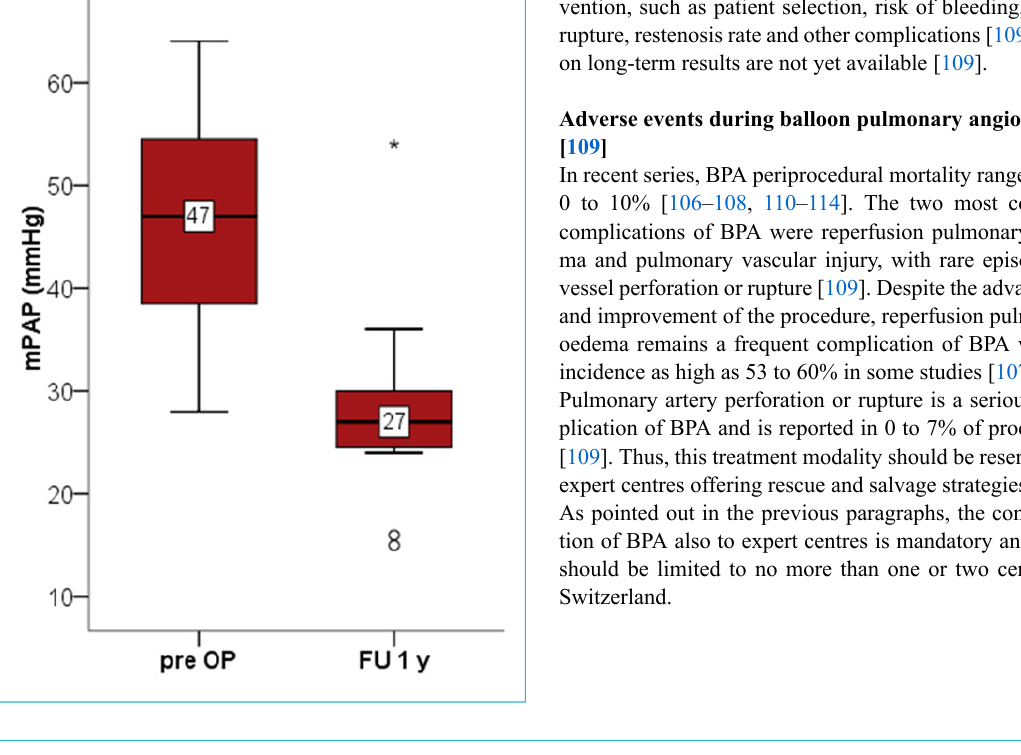
Figure 17: Balloon pulmonary angioplasty angiography demonstrating a well-perfused segment of a left sided pulmonary artery segment after dilatation. (Courtesy of Prof. T.